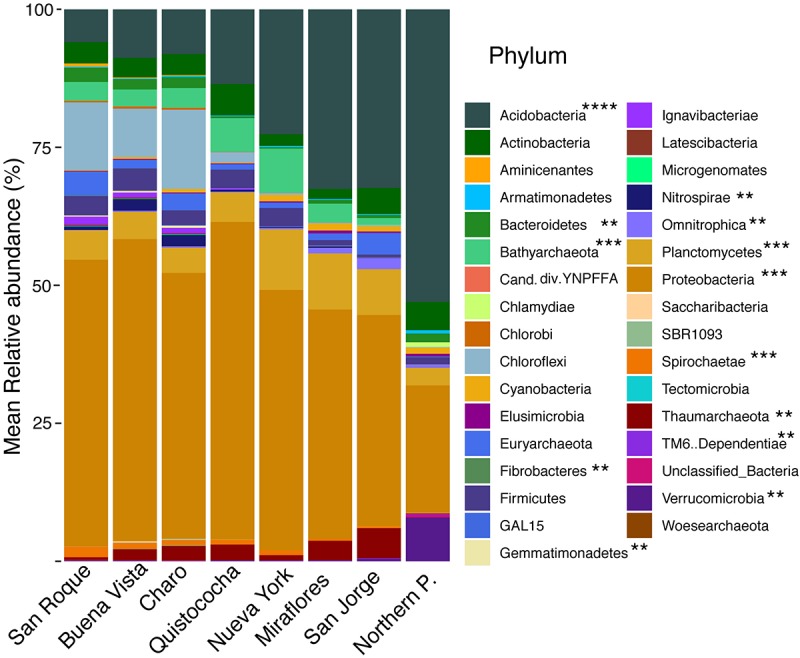
Stacked barplot of relative abundances (%) of Bacterial and Archaeal phyla across the Pastaza-Marañón Basin. Significant differences between phyla in the minerotrophic, mixed, ombrotrophic and Northern peatland groups are shown as: (**) differences between two groups; (***) differences between three groups; and (****) all groups differed. Phyla above 0.005% are shown. Relative abundances are the mean of six independent measurements for Amazon soils, and four for the Northern peatland soil.